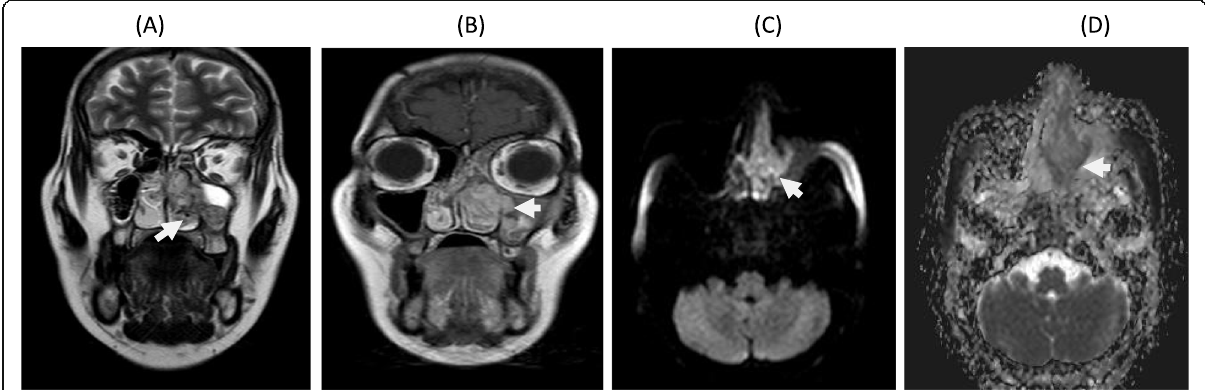
Fig. 2 Pathologically proven recurrent spindle cell sarcoma of the left maxilla following chemoradiation. a Coronal T2-weighted image (T2WI) showing a newly developed lesion of intermediate-to-low signal intensity at the left maxillary antrum and nasal cavity. b Coronal T1-weighted image (T1WI) post-contrast sequence showing inhomogeneous enhancement of the lesion. c Diffusion-weighted imaging (b1000) revealing the hyperintense pattern of the lesion. d Apparent diffusion coefficient (ADC) map revealing the hypointense pattern of the lesion, with a mean ADC value of 1.01 × 10 − 3 /mm 2 suggestive of tumour recurrence